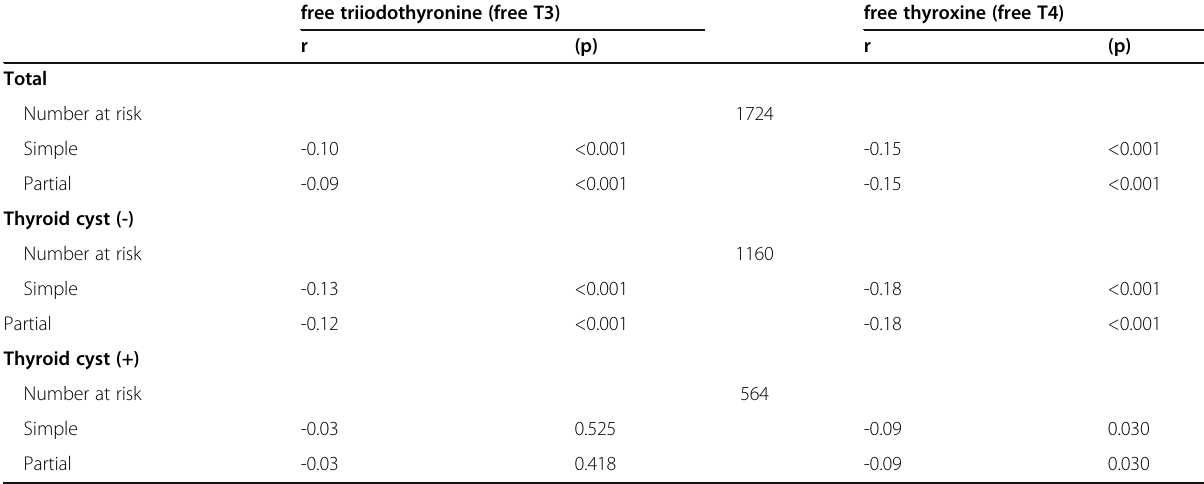
Table 2 Correlations between thyroid stimulating hormone (TSH) and thyroid hormones free triiodothyronine (free T3)